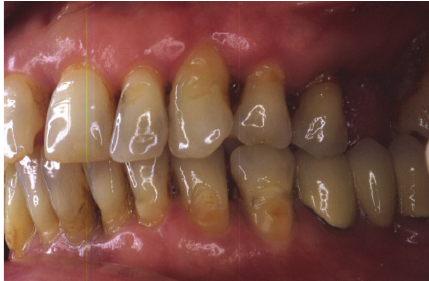
Figure 1: Initial case: clinical frontal view of the patient as she presented in May 2000.